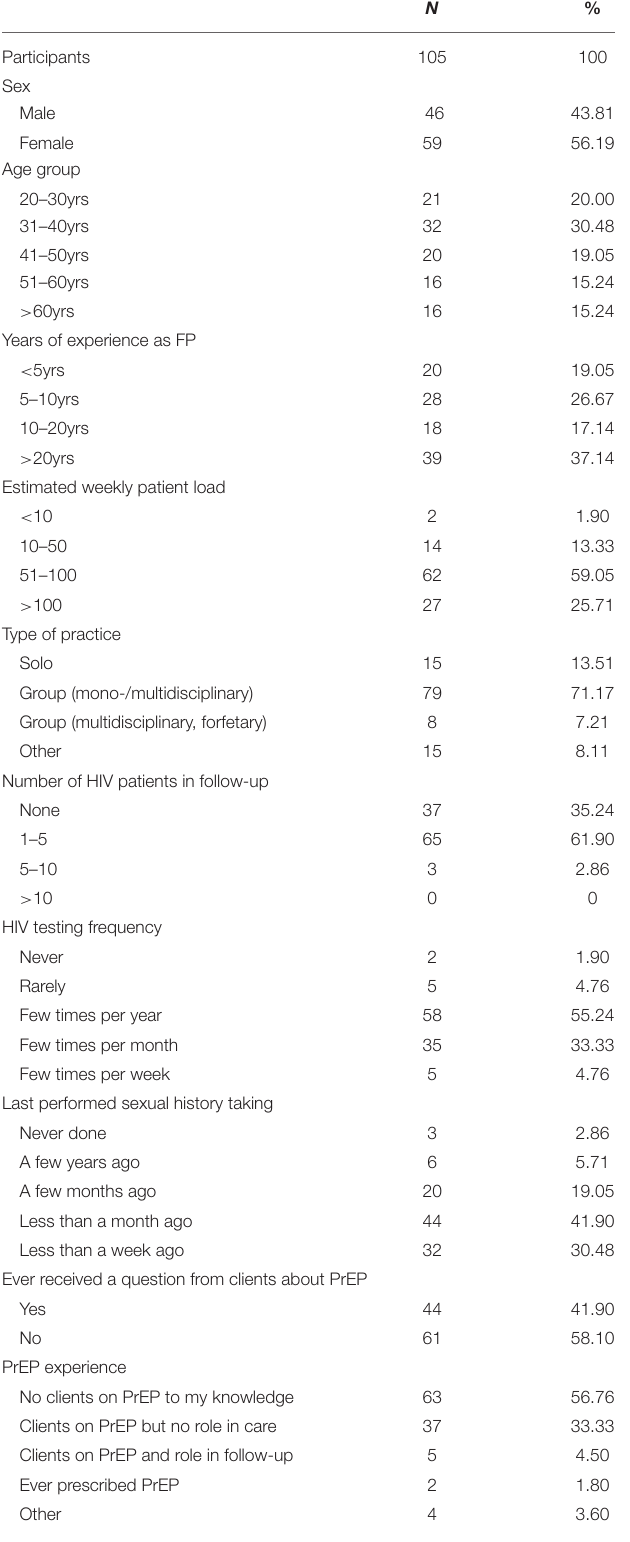
TABLE 1 | Socio-demographics and reported sexual health care experience of FGD